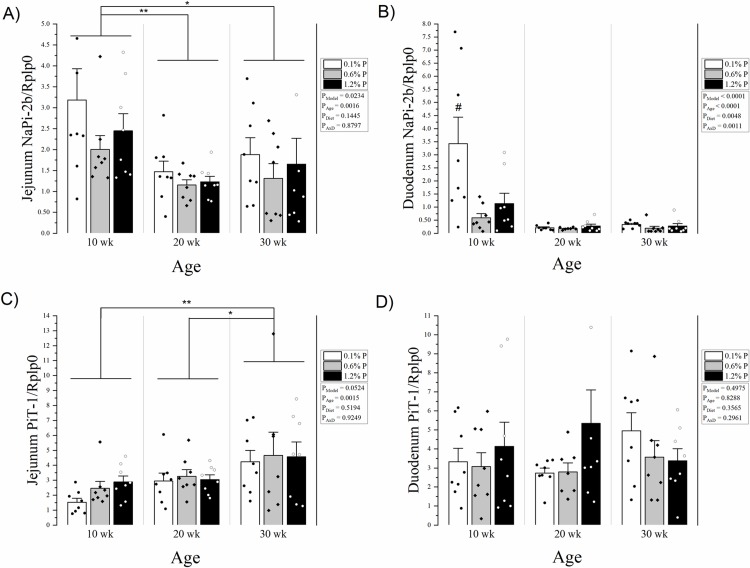
A) Jejunal NaPi-2b mRNA expression by age and dietary phosphorus intake level. There was a main effect for age where 10 week old rats had higher NaPi-2b expression compared to both 20 and 30 week olds, but there was no significant effect of dietary phosphorus intake level and no significant age x diet interaction. B) Duodenal NaPi-2b mRNA expression by age and dietary phosphorus intake level. There was a significant interaction driven by a higher expression in 10 week rats on a low phosphorus diet. C) Jejunal PiT-1 mRNA expression by age and dietary phosphorus intake level. The overall model approached significance, with a main effect for age where 30 week old rats had higher PiT-1 expression compared to both 20 and 10 week olds, but there was no significant effect of dietary phosphorus intake level and no significant age x diet interaction. D) Duodenal PiT-1 mRNA expression by age and dietary phosphorus intake level. There were no differences in age, diet, or interaction. Expression was calculated relative to Rplp0. Means and standard error bars are shown for each group. Low phosphorus diet (0.1%) is shown in white bars and black dots; normal phosphorus diet (0.6%) is shown in grey with black diamonds; and high phosphorus diet (1.2%) is shown in black with white circles. ANOVA p-values for the overall model (PModel), main effect of age (PAge), main effect of diet (PDiet), and interaction of age and diet (PAxD) are shown. * p < 0.05, ** p < 0.01, # p < 0.01 vs all other groups. n = 1 duodenum NaPi-2b and PiT-1 excluded for missing sample.